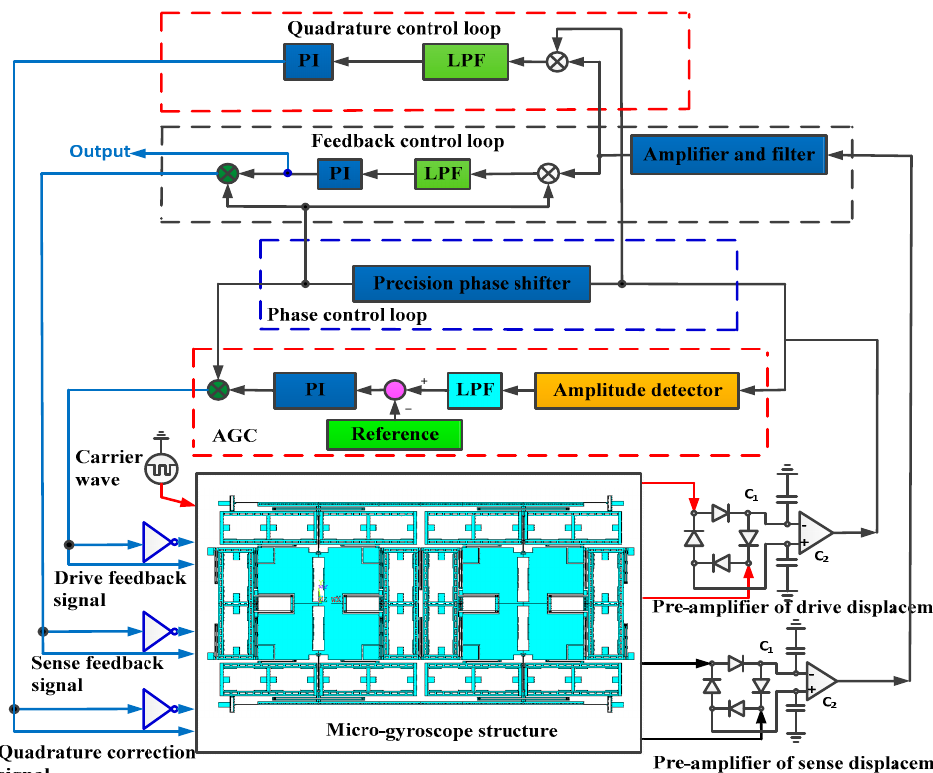
Figure 9. Scheme of the quadrature correction and feedback control circuits.